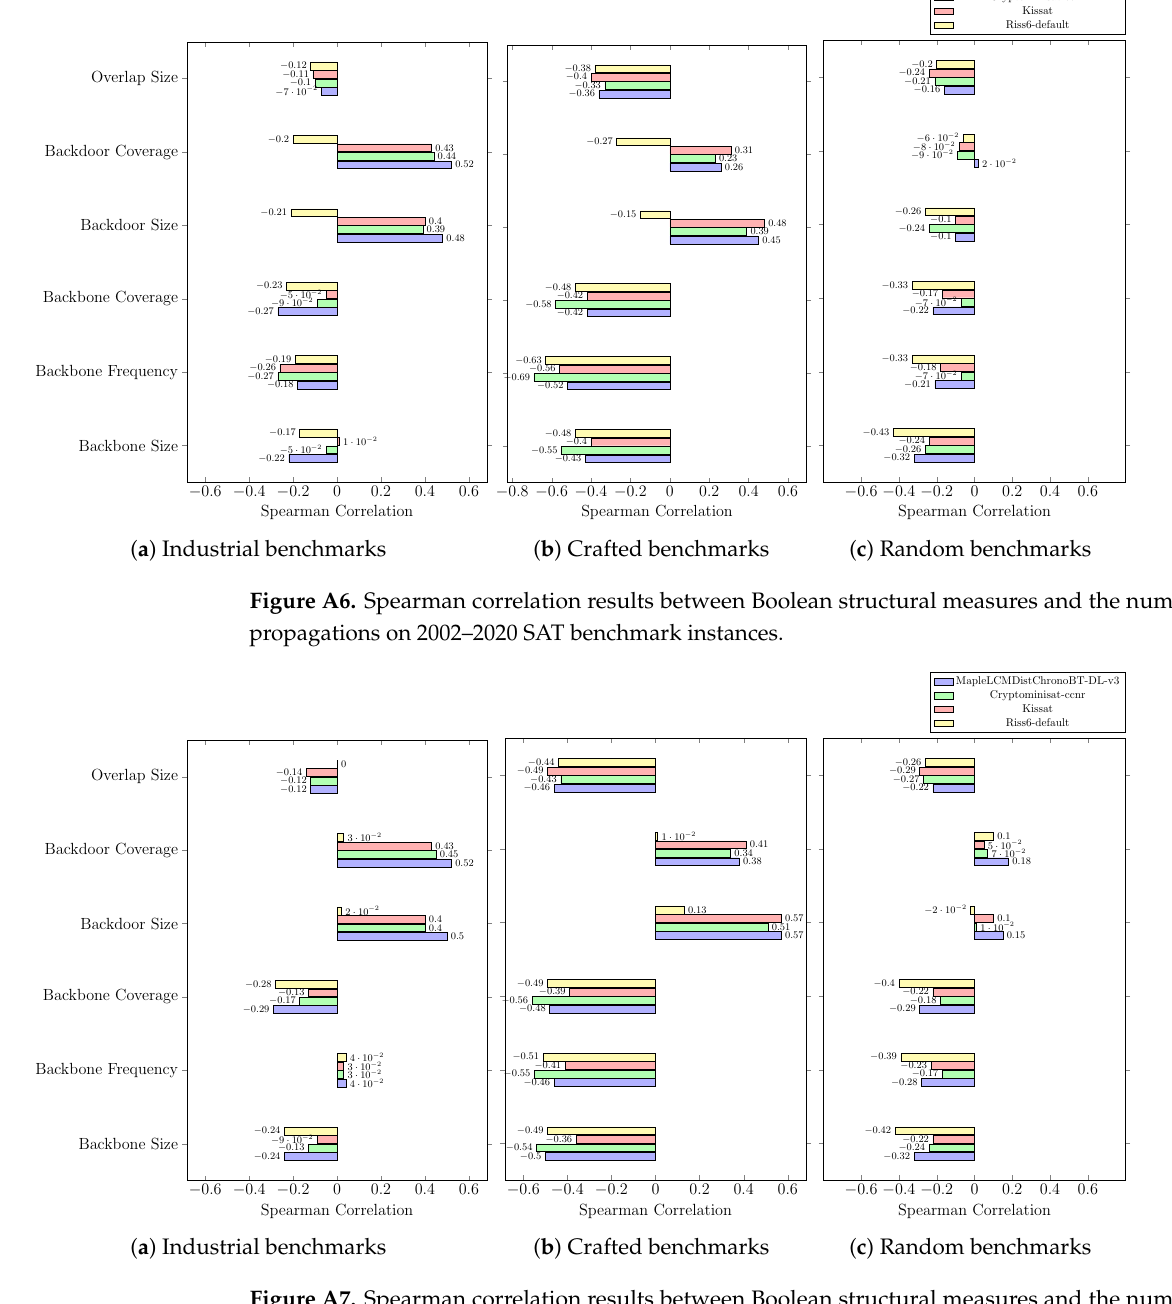
Figure A7. Spearman correlation results between Boolean structural measures and the number of conflicts on 2002–2020 SAT benchmark